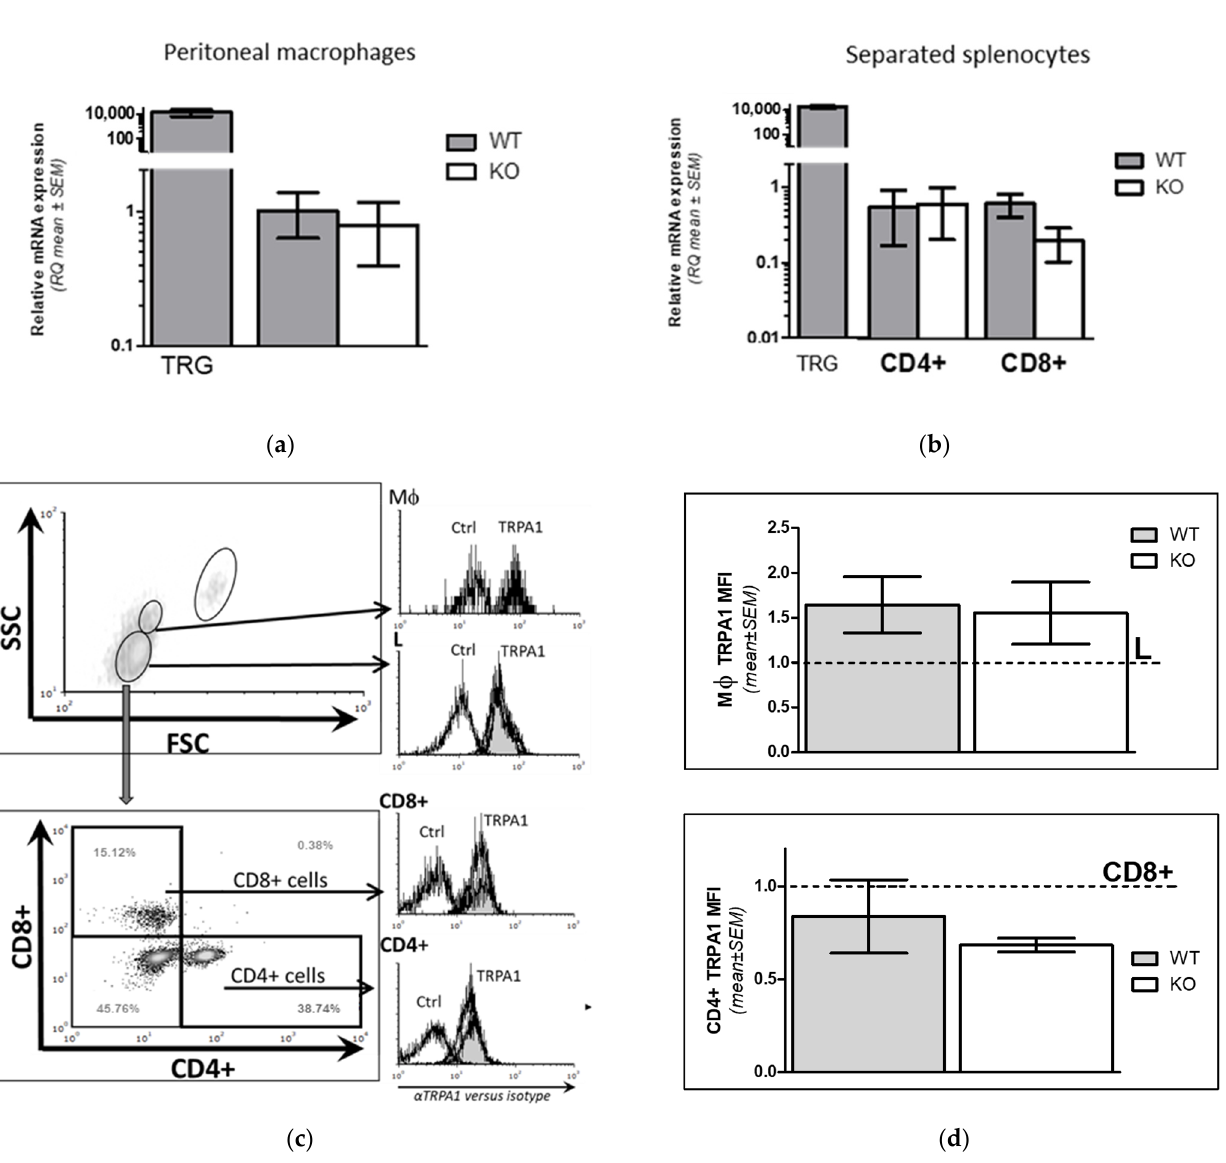
Figure 2. Analysis of TRPA1 expression in wild type and functional KO mice. ( a , b ) Quantitative RT-PCR analysis of relative mRNA (RQ) level and ( c , d ) TRPA1 protein expression. ( a , b ) Comparison of RQ of KO mice to that of wild type (WT) by using primers amplifying both wild type and truncated mRNA in KO mice ( a ) in peritoneal macrophages or ( b ) in separated CD4+ and CD8+ mononuclear cells isolated from spleen. Relative expression levels in these experiments were calculated as fold changes (RQ) referred to mRNA expression in monocyte/macrophage fractions of WT peritoneal cells. ( c ) Gating strategy and representative flow cytometry plots and histograms of peripheral blood cells stained by antibodies to CD4+, CD8+ and TRPA1 or isotype control (Ctrl) antibodies. ( d ) Comparison of TRPA1 protein expression of wild type (WT) to that of KO mice. Upper panel shows specific TRPA1 staining in macrophages relative to lymphocytes (dotted line -- L), lower panel shows that of CD4+ T cells relative to CD8+ cells (dotted line – CD8). Specific labelling of TRPA1 was calculated as mean fluorescent intensity (MFI) of Ctrl expression subtracted from MFI of TRPA1 staining. Data are presented as mean ± SEM, ( a ) n = 4, ( b ) n = 4, ( d ) n = 3. No significant differences in TRPA1 mRNA and protein expression were detected between samples from WT and KO cells by using primers amplifying both wild type and truncated mRNA and antibody recognizing the first 100 amino acids of the channel.